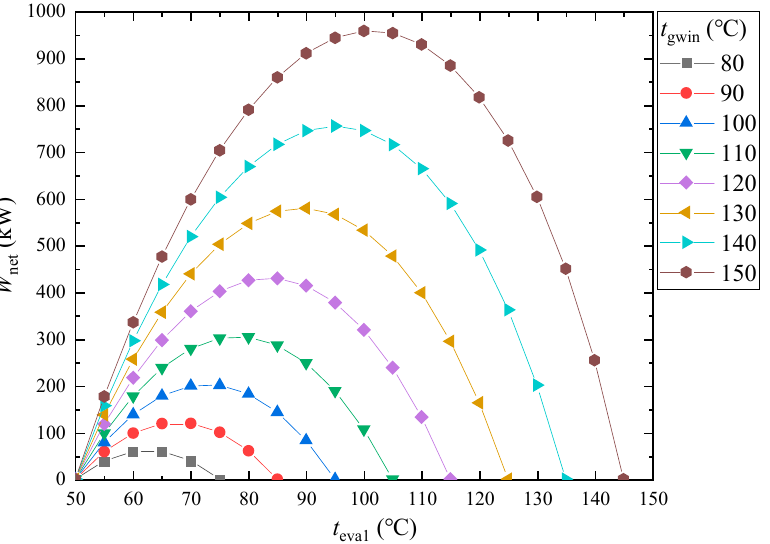
Figure 3. Effect of geothermal fluid temperature and evaporation temperature of evaporator 1 on net power output of turbine.